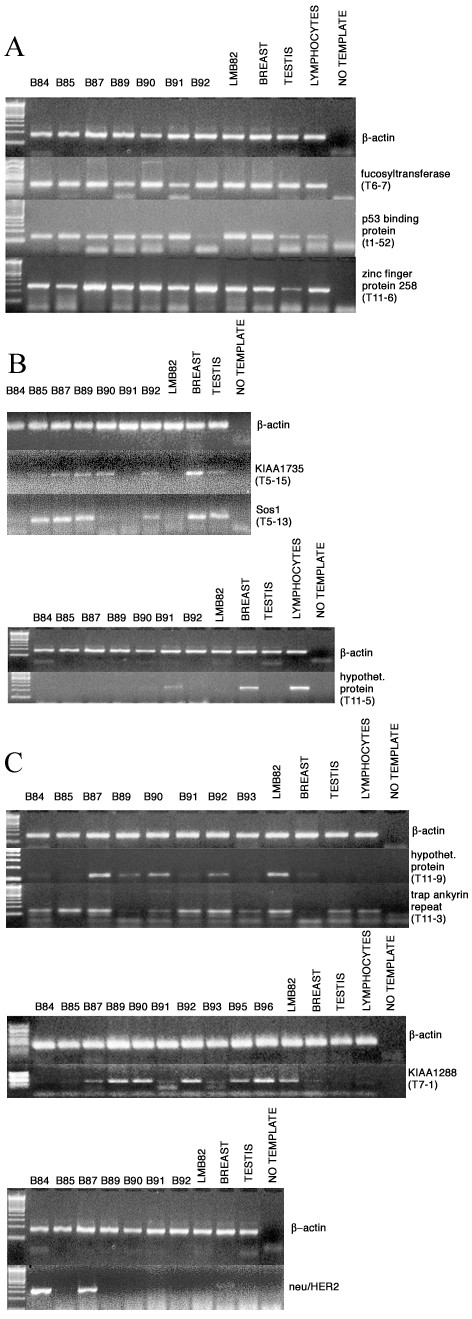
cDNA-PCR analysis of gene expression was done using specific sequence primers. We used SMART cDNAs from 7–10 different tumor samples (patients B84, B85, B87, B89, B90, B91, B92, B93, B95, B96) as template, from single metastasized lymph node indicated as LMB82 (patient B82) and from normal breast, normal testis, lymphocytes from healthy donors. cDNAs were normalized by amplification of β-actin gene. There are agarose gels with ubiquitously-expressed genes in Figure 5A, underexpressed genes in Figure 5B, overexpressed ones in Figure 5C.